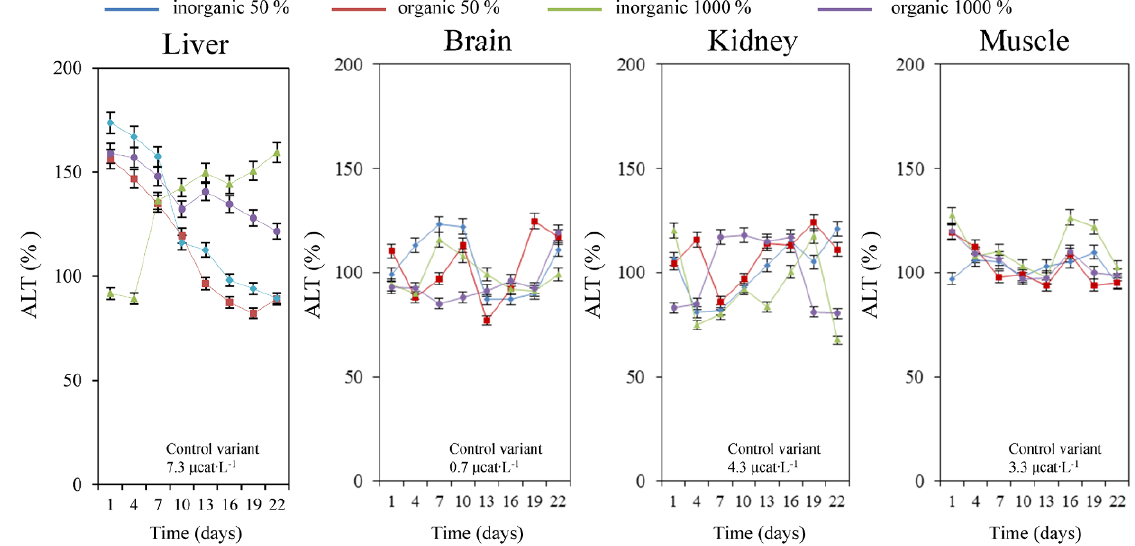
Figure 6. ALT activity in the examined organs. The level was related to the controls. Error bars indicate standard error of mean for three specimens. ALT was determined by spectrometric assay. . The ALT activity results were related to a control group and recalculated as a percentage of control. Control group was determined as a one hundred percent from individual values as follows: liver 7.3 μcat L -1 , brain 0.7 μcat L -1 , kidney 4.3 μcat L -1 and muscle 3.3 μcat L -1